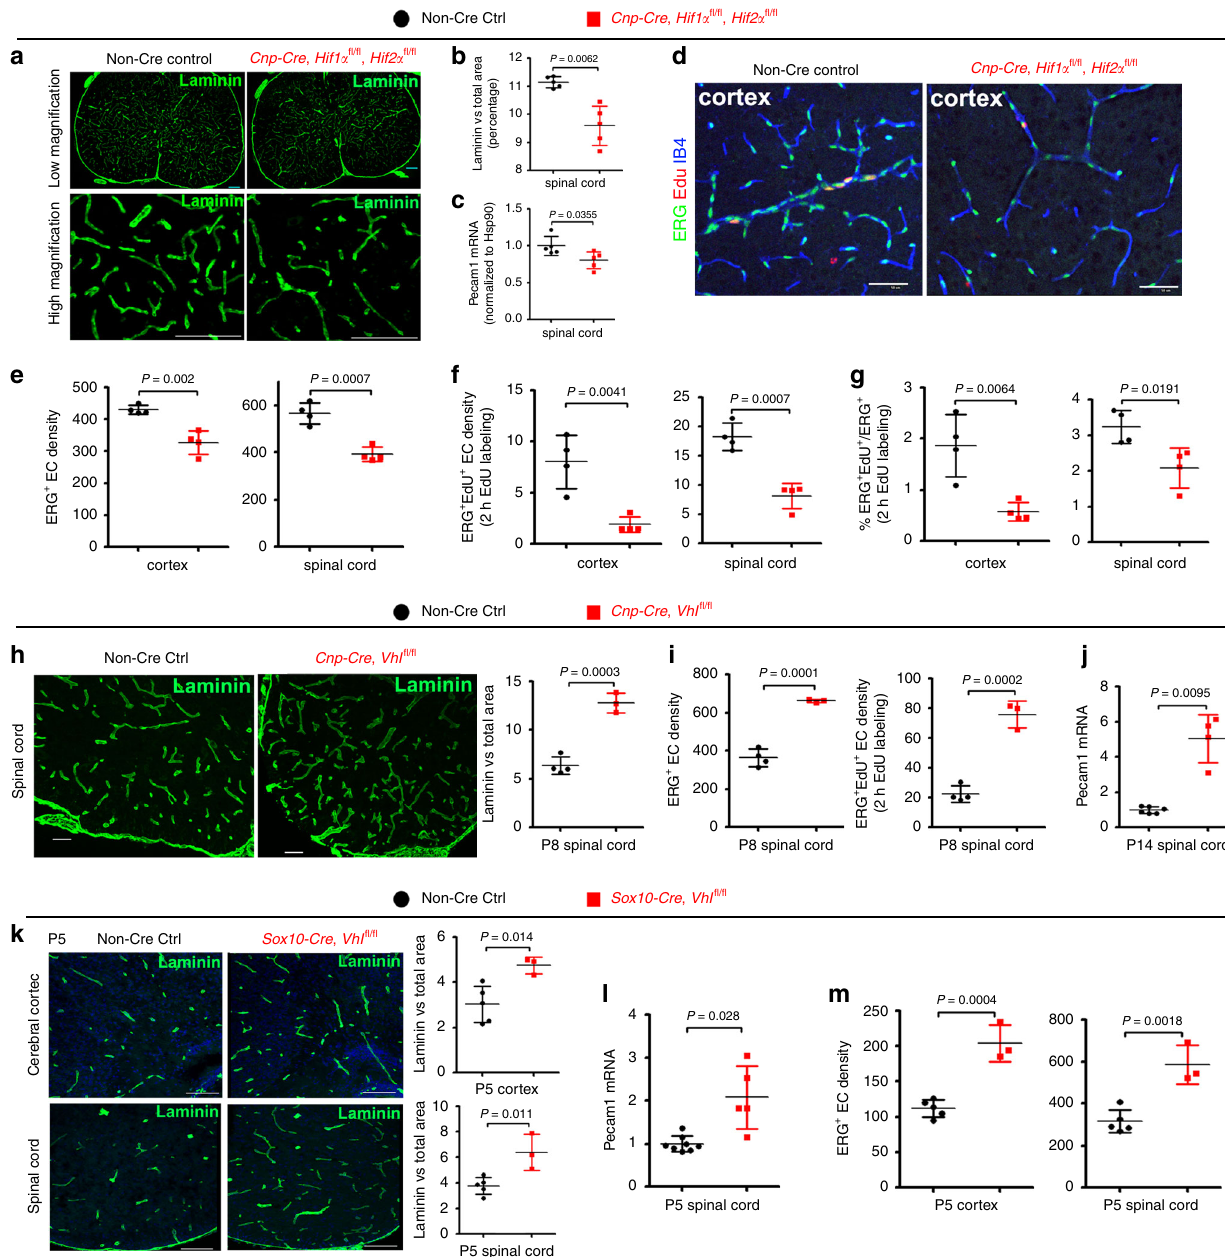
Fig. 1 CNS region-independent regulation of angiogenesis by oligodendroglial HIF α . a Representative images of blood vessels labeled by the basement membrane marker Laminin in the spinal cord of Cnp-Cre:Hif1 α fl / fl : Hif2 α fl / fl and non-Cre littermate controls at postnatal day 14 (P14). Scale bars = 100 μ m. b Percentage of Laminin + area among total assessed area. Two-tailed Student ’ s t test with Welch ’ s correction, t (4.618) = 4.767, n = 5 each group. c RT- qPCR assay of Pecam1 mRNA (a.k.a. CD31), a marker of endothelial cells (ECs), in the P14 spinal cord. Two-tailed Student ’ s t test, t (8) = 2.526, n = 5 each group. d – f Representative images of immunohistochemical staining of ERG (a nuclear marker of ECs), isolectin B4 (IB4, labeling blood vessel basement membrane), and EdU (labeling actively dividing cells) and densities of marker positive cells (# per mm 2 ) in Cnp-Cre, Hif1 α fl / fl , Hif2 α fl / fl and littermate control mice at P14. Two hours EdU pulse labeling. Two-tailed Student ’ s t test, ERG + , t (6) = 5.200 cortex, t (6) = 6.358 spinal cord; ERG + EdU + , t (6) = 4.496 cortex, t (6) = 6.365 spinal cord. n = 4 each group. g Percentage of ERG + ECs that are EdU + . Two-tailed Student ’ s t test, t (6) = 4.089 cortex, t (6) = 3.181 spinal cord. n = 4 each group. h Representative images and quanti fi cation of Laminin in the spinal cord of P8 Cnp-Cre, Vhl fl / fl , and non-Cre control mice. Two-tailed Student ’ s t test, t (5) = 8.831. n = 4 Ctrl, 3 VHL cKO. i Densities (per mm 2 ) of ERG + ECs and ERG + EdU + proliferating ECs in the P8 spinal cord. Two-tailed Student ’ s t test, t (5) = 11.10 ERG + , t (5) = 9.981 ERG + EdU + . n = 4 Ctrl, 3 VHL cKO. j RT-qPCR of Pecam1 mRNA in P14 spinal cord. Two- tailed Student ’ s t test with Welch ’ s correction, t (3.081) = 5.941. n = 6 Ctrl, 4 VHL cKO. k Representative images and quanti fi cation of Laminin in P5 Sox10- Cre, Vhl fl / fl and non-Cre controls. Two-tailed Student ’ s t test, t (6) = 3.625 spinal cord, t (6) = 3.428 cortex. n = 5 Ctrl, 3 VHL cKO. l RT-qPCR of Pecam1 mRNA in P5 spinal cord. Two-tailed Student ’ s t test with Welch ’ s correction, t (4.309) = 3.257. n = 8 Ctrl, 5 VHL cKO. m Densities (per mm 2 ) of ERG + ECs at P5. Two-tailed Student ’ s t test, t (6) = 6.964 cortex, t (6) = 5.324 spinal cord. n = 5 Ctrl, 3 VHL cKO. Scale bar: a , k 100 μ m; d , h 50 μ m. Data are shown as mean ± s.d. Source data of b , c , e , m are provided as a Source Data fi le.